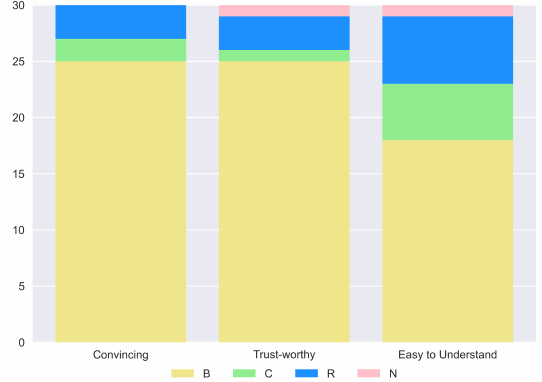
Figure 20. Bar chart of the preferences for actual explanations chosen by the participants for three different aspects.